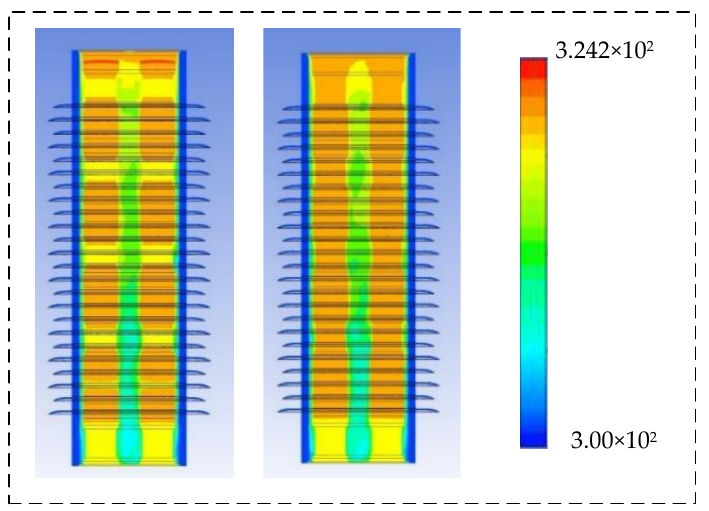
Figure 17. The temperature distribution of the arrester at the 35th second and 86th second after the transient impact.